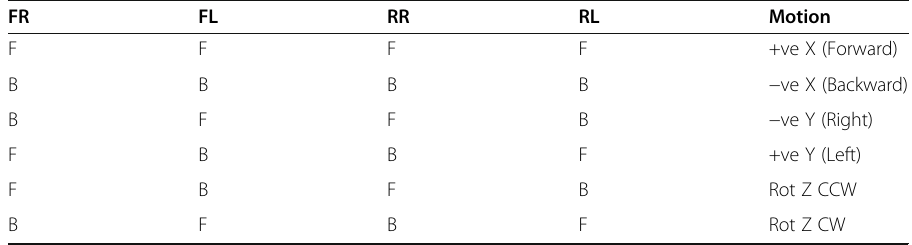
Table 1 Planner thrusters ’ operation modes